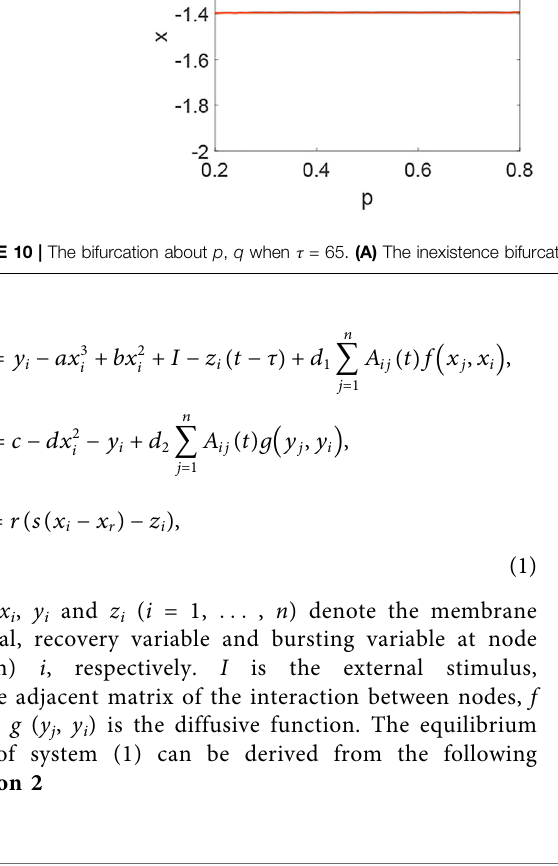
Frontiers in Physiology |